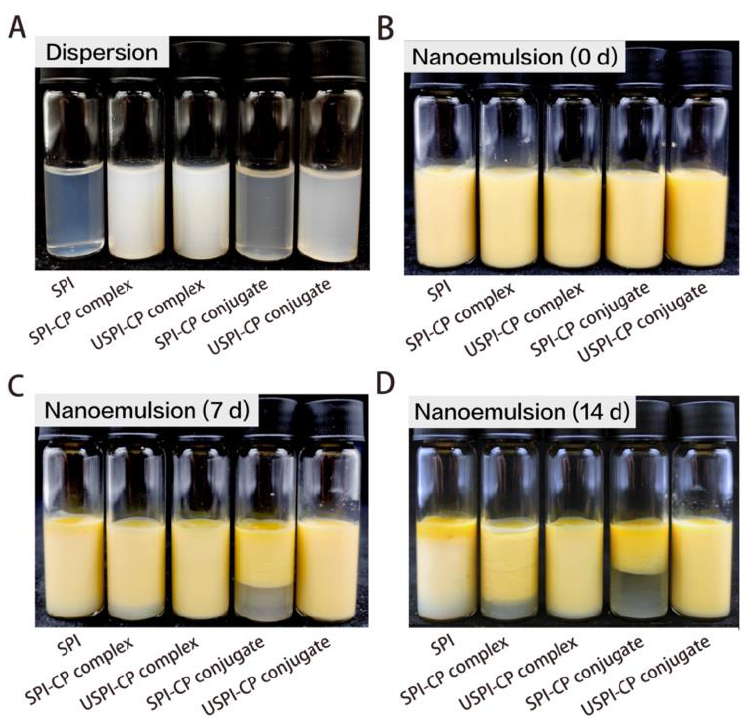
Figure 5. Images of original dispersions of SPI, SPI–CP complex, USPI–CP complex, SPI–CP conjugate and USPI–CP conjugate, respectively ( A ), and images of β -carotene nanoemulsions stabilized by different emulsifiers stored at 25 ◦ C without direct light irradiation for 0 d ( B ), 7 d ( C ) and 14 d ( D ), respectively. Samples: SPI, soy protein isolate; SPI–CP complex, electrostatic complex formed between soy protein isolate and citrus pectin; USPI–CP complex, electrostatic complex formed between soy protein isolate and citrus pectin with ultrasound treatment; SPI–CP conjugate, Maillard-type conjugate formed between soy protein isolate and citrus pectin; USPI–CP conjugate, Maillard-type conjugate formed between soy protein isolate and citrus pectin with ultrasound